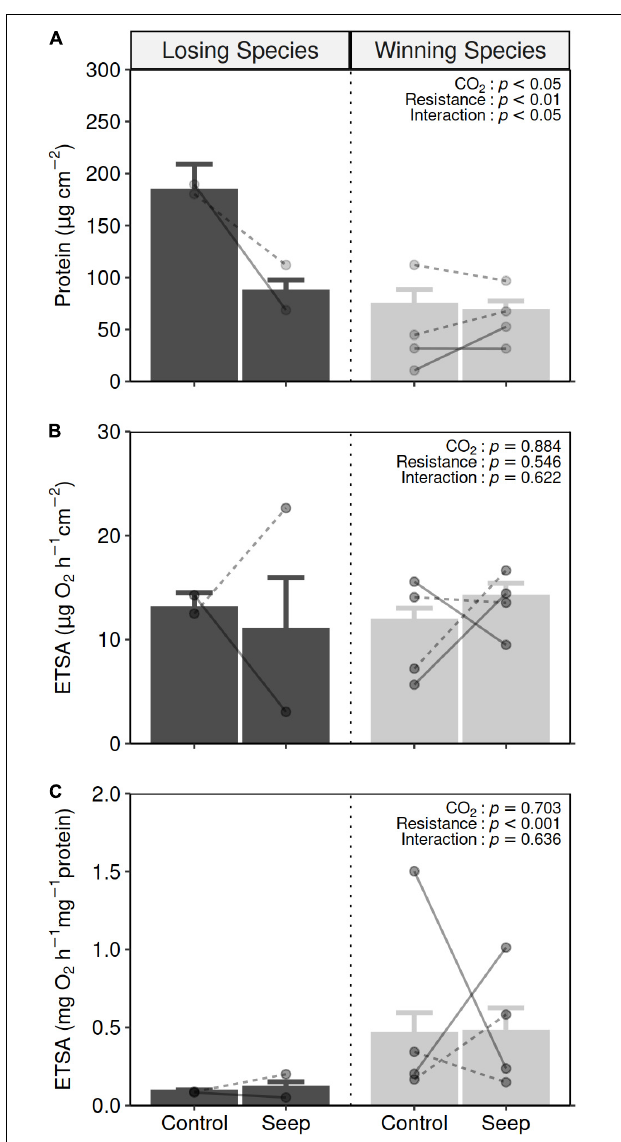
FIGURE 4 | Mean ( ± SE) protein per surface (A) , ETSA per coral surface area (B) and ETSA per protein contents (C) in losing species (black bars) and winning species (gray bars) species sampled at the control areas (control) and elevated p CO 2 areas (seep) (losing species specimens: control n = 14, seep n = 5; winning species specimens: control n = 20, seep = 16). Points and lines show the mean and response per species with dashed and plain lines representing species from Shikine and Normanby sites, respectively (see Supplementary Table 5 ). Two-way GLMM (CO 2 condition x resistance with Species as a random factor) results are presented in the top-right of each panel (see Supplementary Table 6 for more detailed statistics).